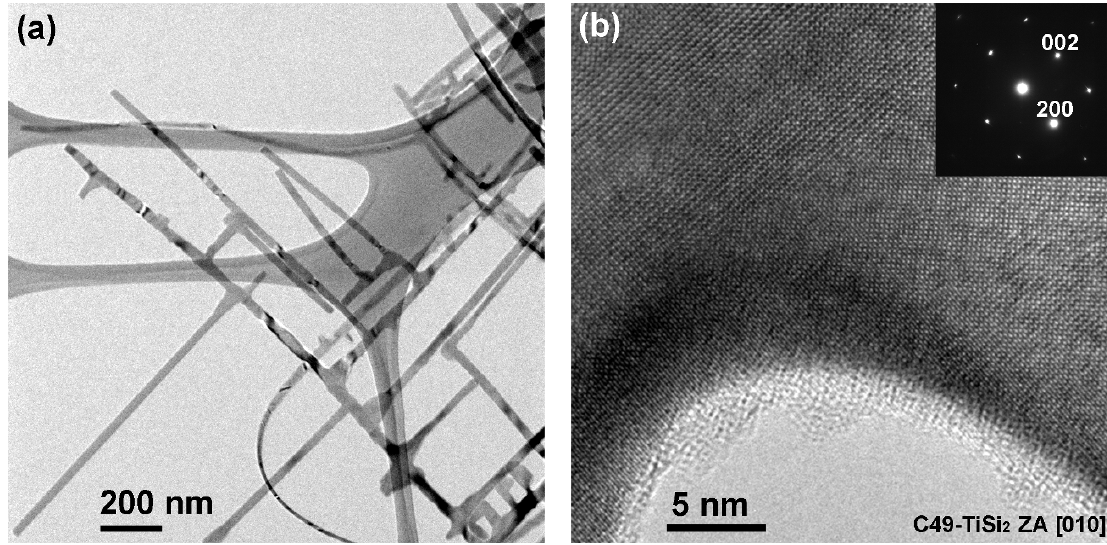
nanonets were obtained by adjusting growth conditions to achieve Figure 4. 2D TiSi 2 desired surface energy differences between various TiSi crystal planes. (a) The 2 morphology is clearly revealed in this low magnification TEM [23]. (b) Atomic lattice resolved high resolution imaging confirms the single-crystalline nature of a junction. The inset electron diffraction pattern was taken along the [010] zone axis (ZA) of the C49 TiSi 2 phase. Reproduced with permission from Angewandte Chemie